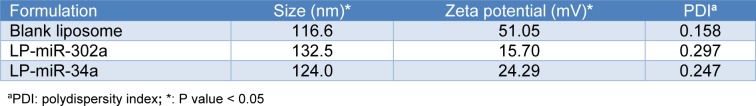
Characterization of the prepared liposomes